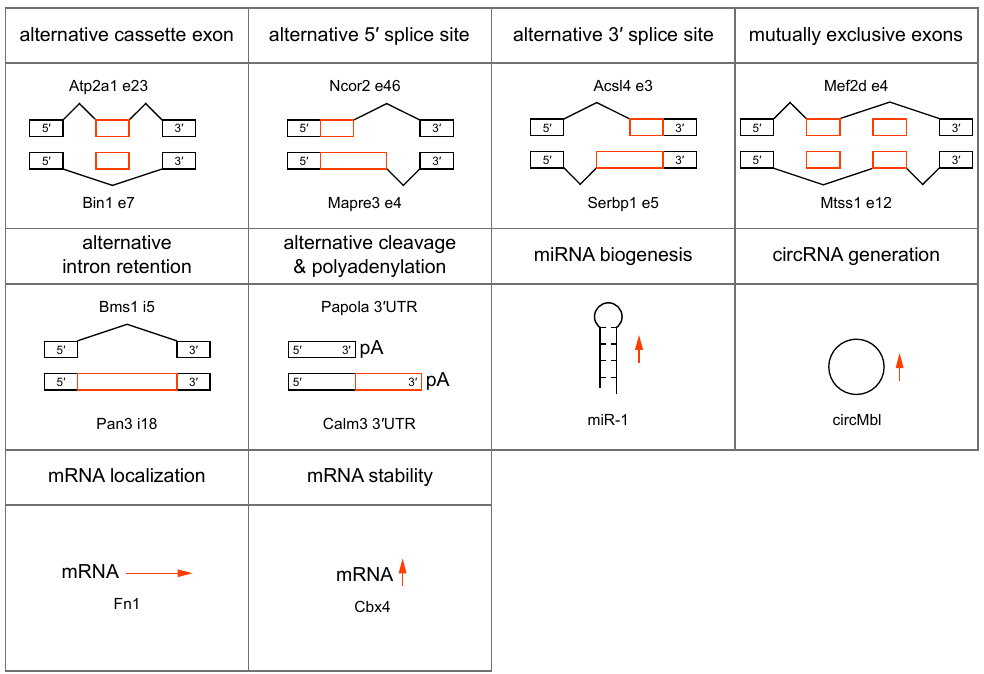
Figure 4. MBNL functions in RNA biogenesis, localization and stability. MBNL regulates alternative (orange boxes) splicing events, including cassette (e) exon, 5 ′ splice site, 3 ′ splice site, mutually exclusive exons, (i) intron retention [121,129] and alternative 3 ′ end formation by alternative cleavage and polyadenylation (pA) [122]. MBNL also regulates microRNA (miRNA) biogenesis [96], circular RNA (circRNA) formation [123], mRNA localization (horizontal arrow) [121] and increases mRNA stability (vertical arrow) [124]. All examples represent MBNL-mediated events and representative targeted RNAs are indicated.